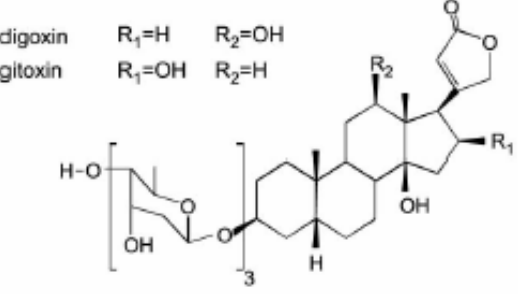
Figure 1. Basic structure of some specific Na + ,K + -ATPase